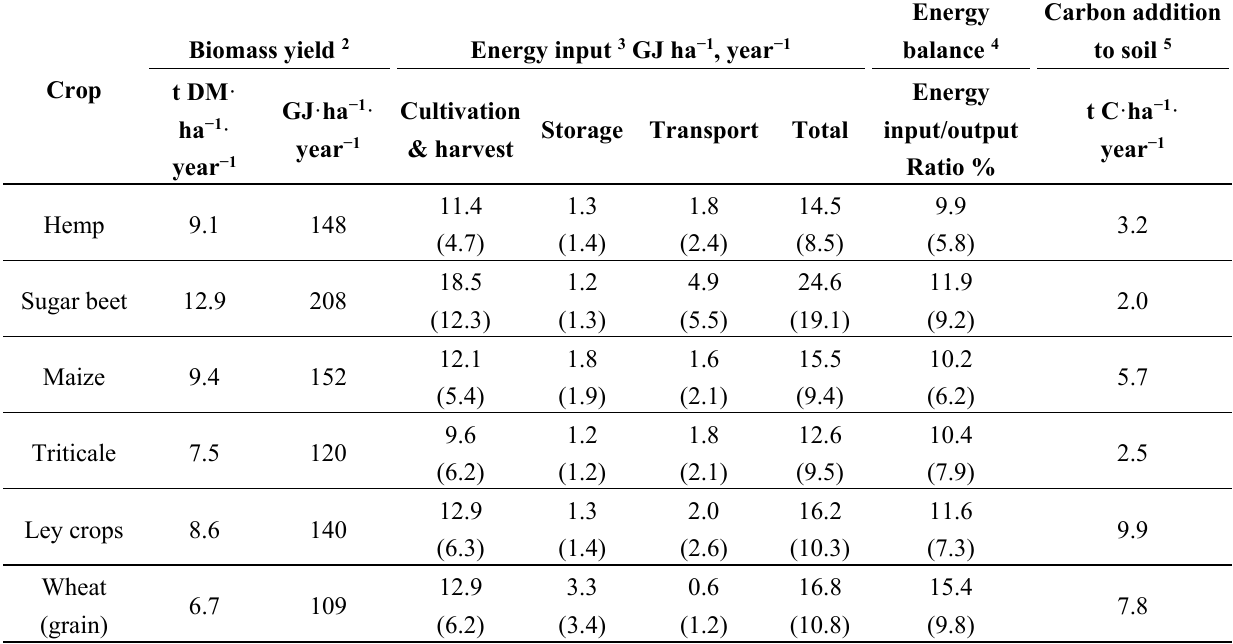
Carbon addition balance 4 to soil